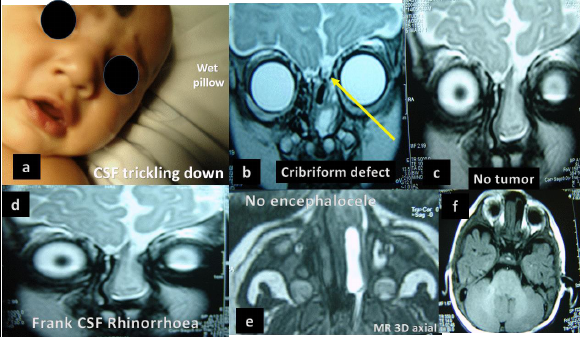
Figure 1: a. Clinical picture showing CSF flowing out of nose, b. MR Coronal showing cribriform defect, c. MR showing no evidence of ICSOL, d. MR showing frank CSF rhinorrhea, e. MR 3d axial showing no Encephalocele, f. MR Showing cranial base.